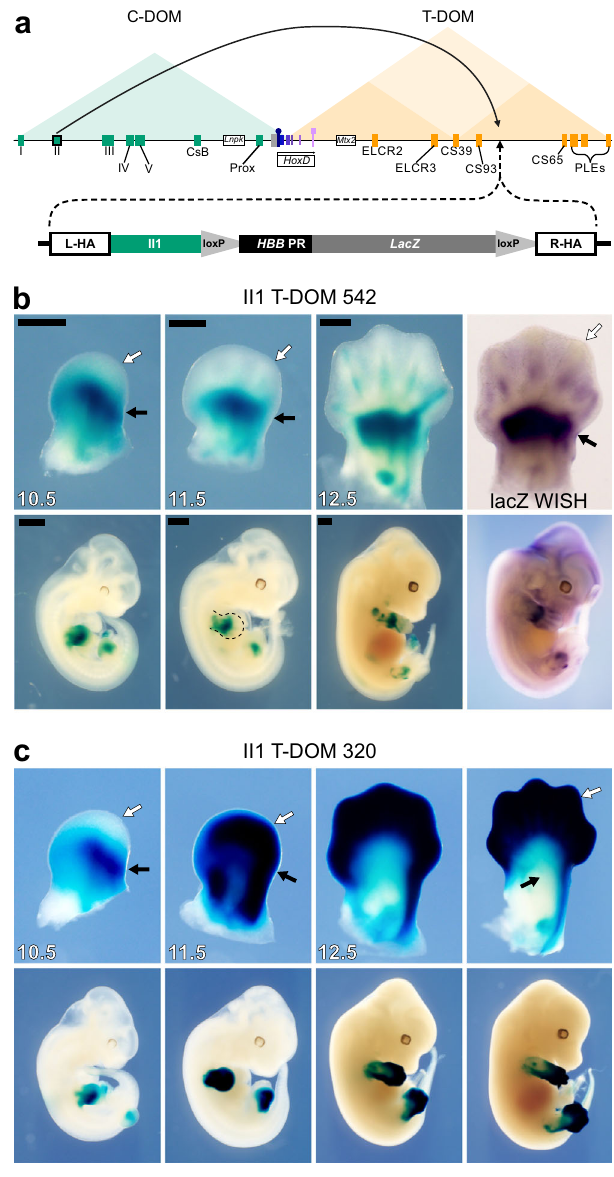
Fig. 2 Targeted recombination of the II1 transgene into T-DOM. a Scheme of the HoxD locus with the triangles indicating the extent of both the C-DOM (green) and T-DOM (orange) TADs. Enhancers are green (distal limbs) or orange (proximal limbs) rectangles and the HoxD cluster is boxed. The arcing arrow on top indicates the origin and new location of the island II enhancer transgene into T-DOM. Below is a map of the II1: HHB:LacZ construct containing left (L-HA) and right (R-HA) homology arms, the II1 enhancer element, and the HBB promoter with a LacZ reporter gene. b B-galactosidase staining time course and LacZ mRNA (right panel) of the single-copy II1 T-DOM 542 founder line. At E10.5 and 11.5, staining is strong in the proximal limb (white arrow) while absent in the distal portion (black arrow). By E12.5 weak staining appears in the digit mesenchyme of the distal limb. The WISH for LacZ mRNA con fi rms that distal limb staining comes from transcription in distal limb cells rather than from stable B-galactosidase activity. c B-galactosidase staining in the multi-copy II1 T-DOM 320 founder line is stronger and more distal, except at the earliest time point where it is more similar to line 542. Black scales bars are 0.5